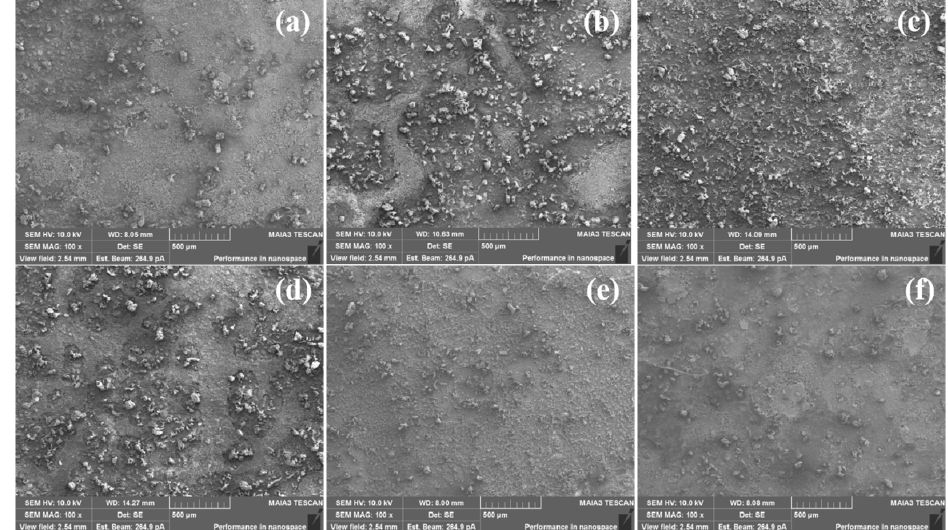
Figure 8. SEM surface morphologies of the samples at different pH values: ( a ) bare steel, 3.10, ( b ) bare steel, 5.15, ( c ) bare steel, 7.18, ( d ) S8 − coated steel, 3.10, ( e ) S8 − coated steel, 5.15, ( f ) S8 − coated steel, 7.18.